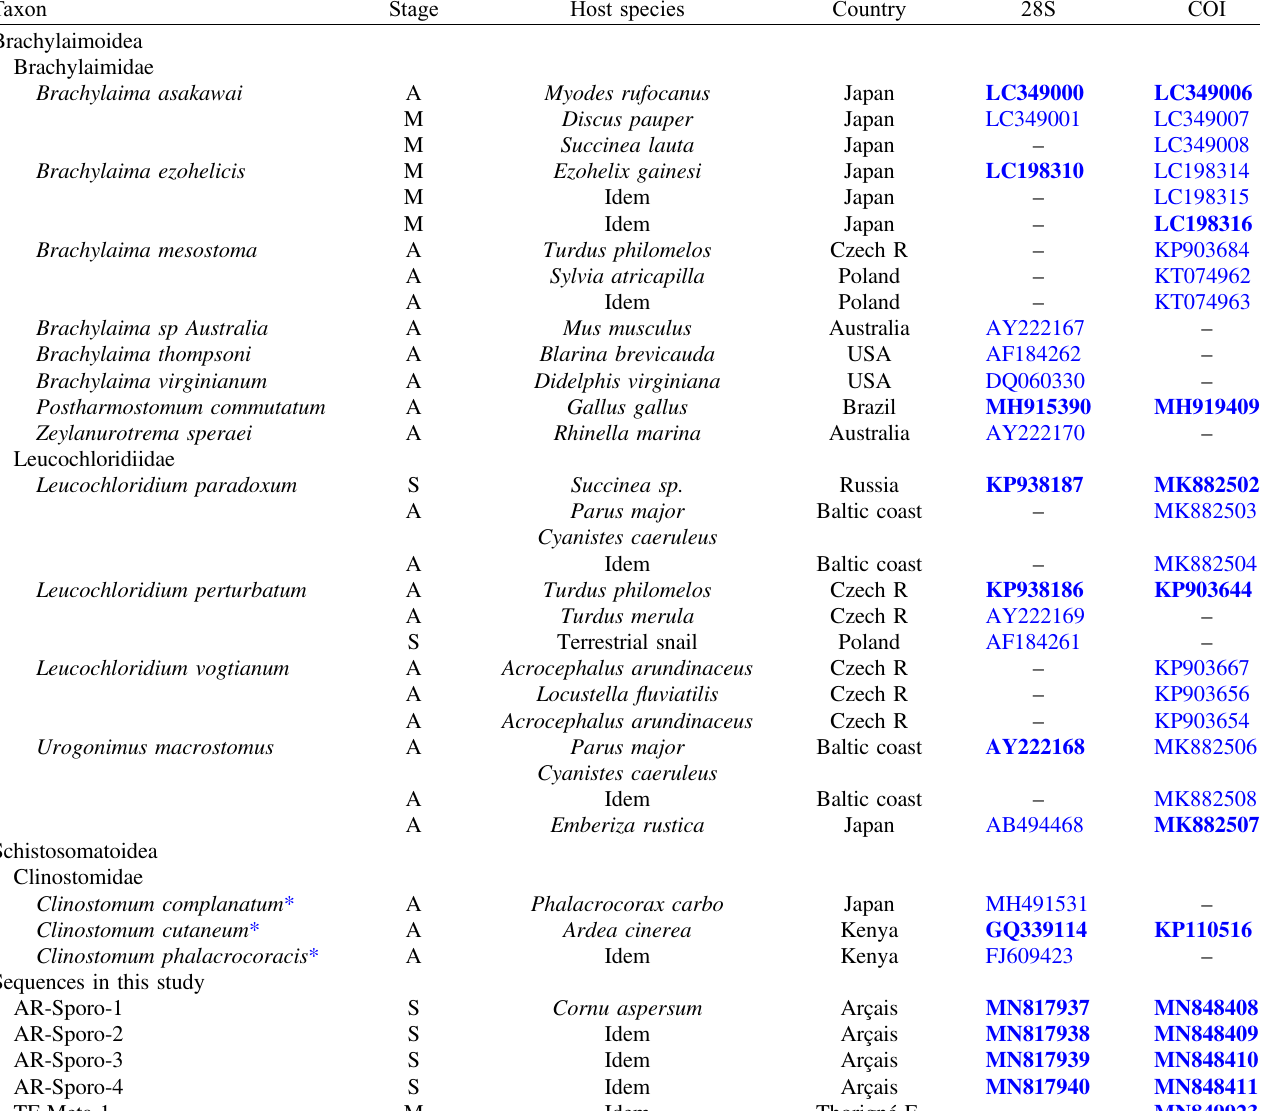
Table 4. Taxonomy and GenBank accession number of the 28S and COI sequences for the species related to our study samples and used in subsequent phylogenetic